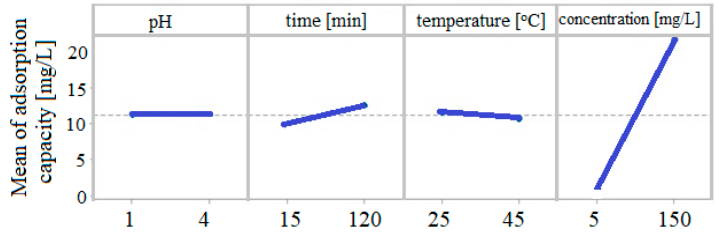
Figure 6. The main effects of the control factors on the adsorption capacity.